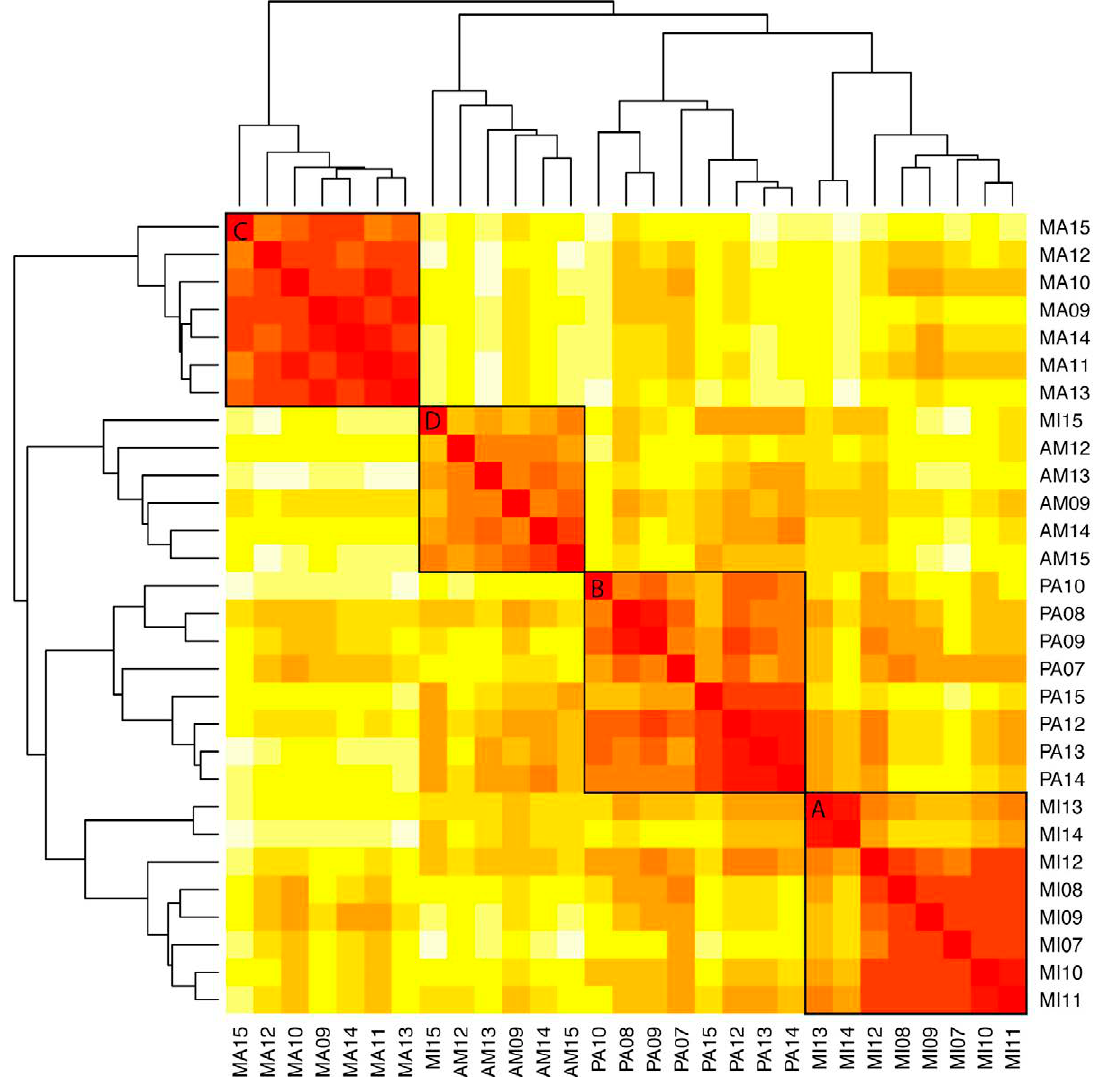
Fig. 3. – Heatmap result of cluster analysis of locations on the basis of species images catch rates. A, B, C and D represent the four main groups identified in the